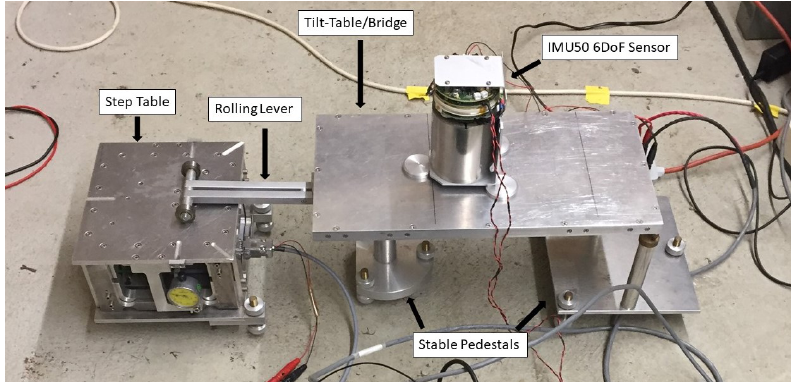
Figure 1. The set up of the sensor on the tilt table for calibration of the FOG components: The step table moves vertically up and down, which tilts the rolling lever, which in turn tilts the bridge or “tilt table” that the sensor sits on. The stationary ends of the rolling lever and tilt table are supported on stable pedestals, all as labelled in the above